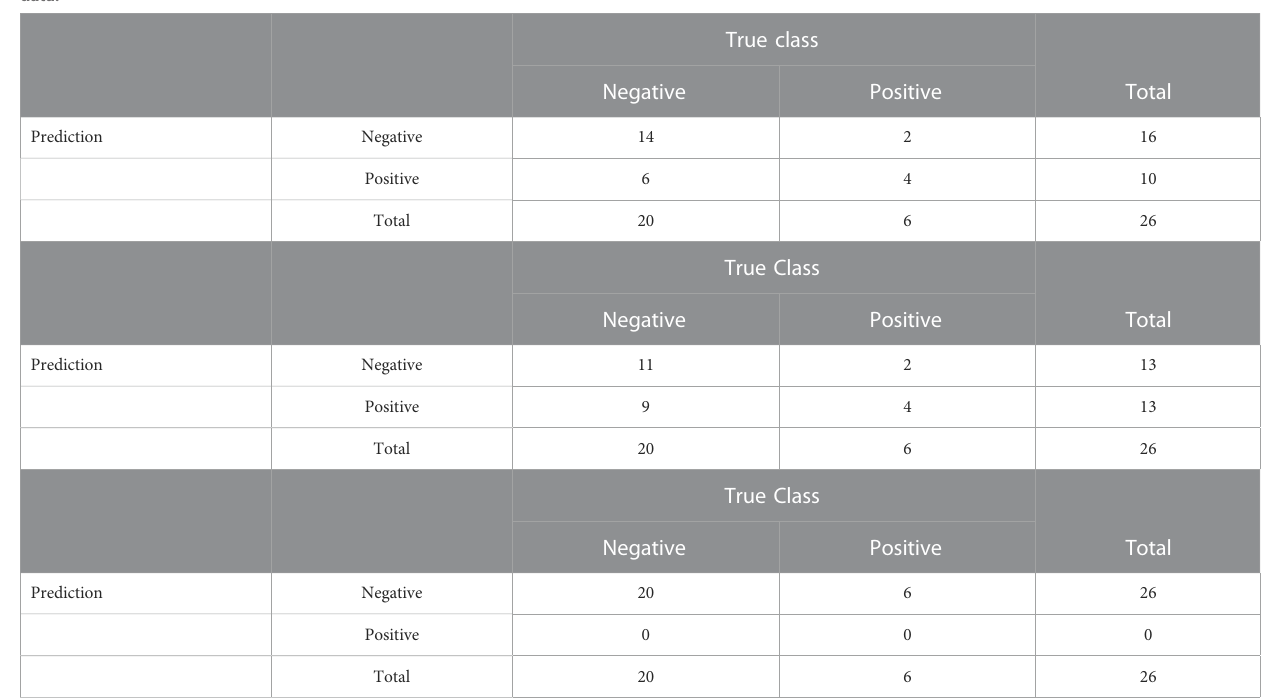
TABLE 6 Confusion matrices for the classi fi cation performance of the proposed RVS model, the Bayesian model with a neutral prior, and lasso on the case study